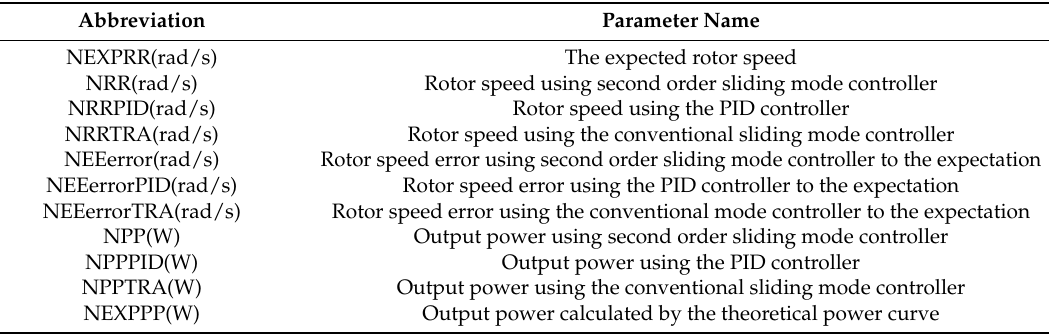
Table 2. Related abbreviations used in the figures.